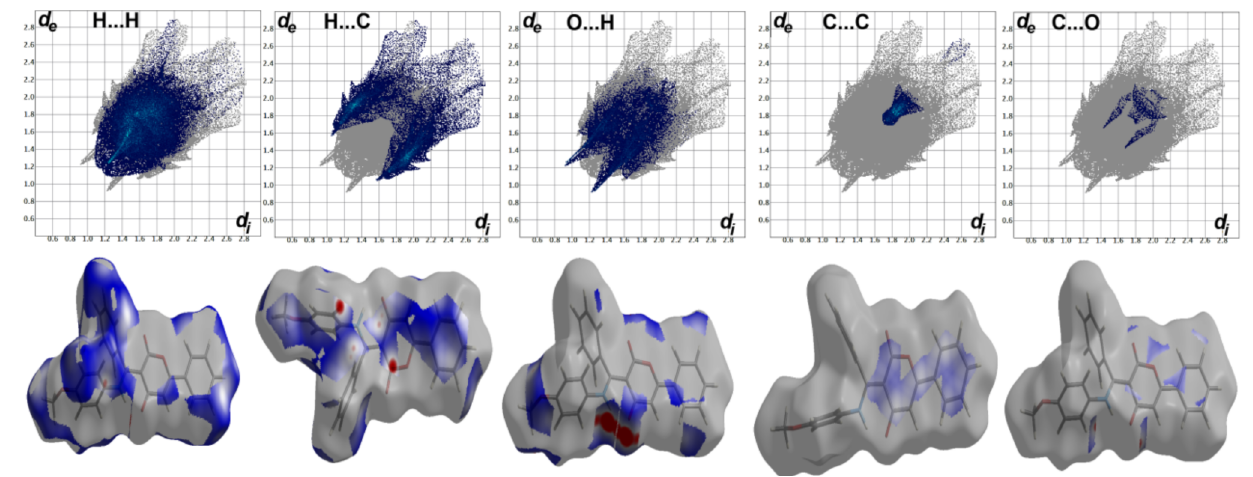
Figure 7. Decomposed fingerprint plots and d norm Hirshfeld surfaces of the most abundant interactions in 2